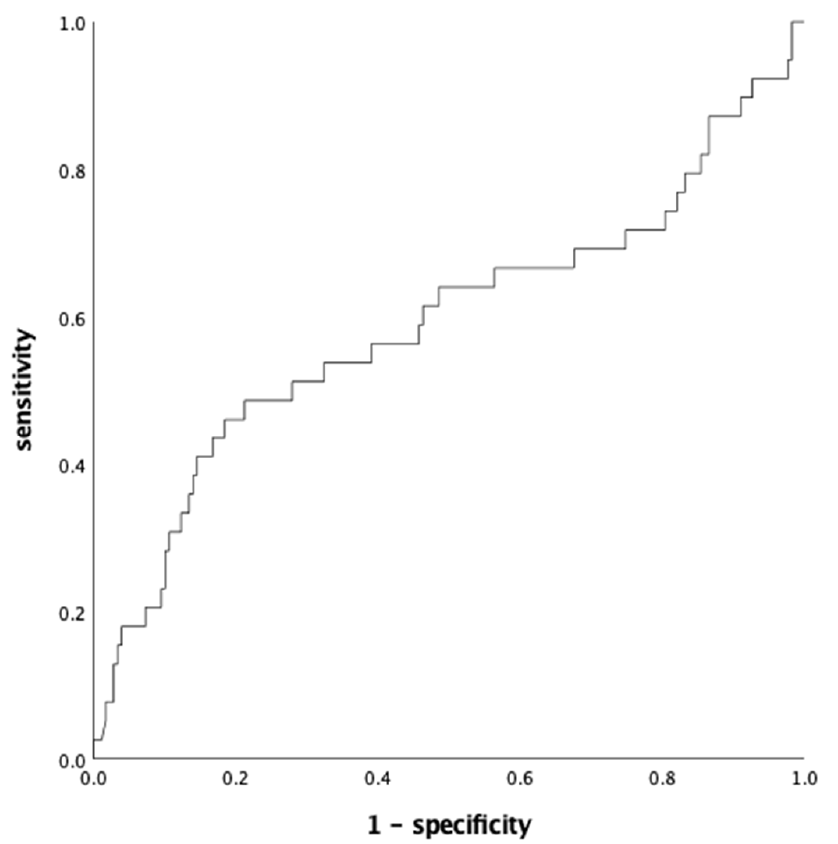
Figure 2. ROC curve with cut-off value of 115 ng/mL NGAL at 11–16 weeks of gestation for the detection of pregnancy hypertension and/or preeclampsia. Table 3. Predictive model for the development of PH or PE: binary logistic regression model ( n =